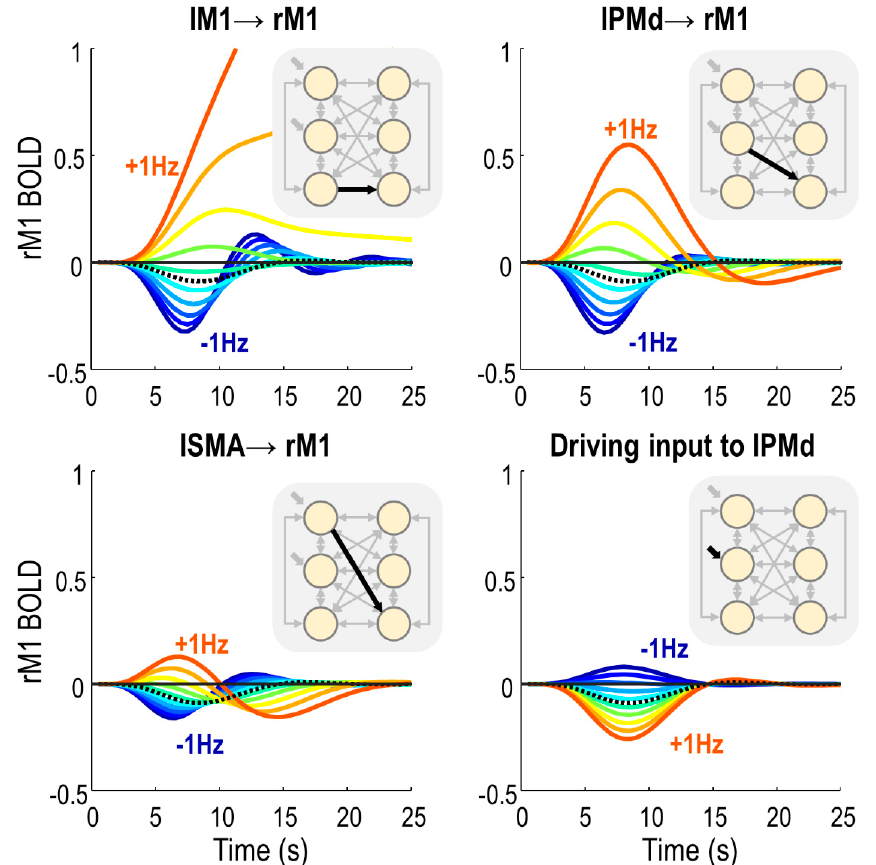
Figure 6. Simulations. Each plot shows the effect of varying one parameter (indicated by the title and the diagram, inset), on the predicted BOLD response in right M1. The black dotted line indicates the predicted BOLD response under the group average parameters for the negative responder group. The coloured lines are simulated BOLD responses, as a consequence of varying each parameter between its estimated value minus 1 Hz, to its estimated value plus 1